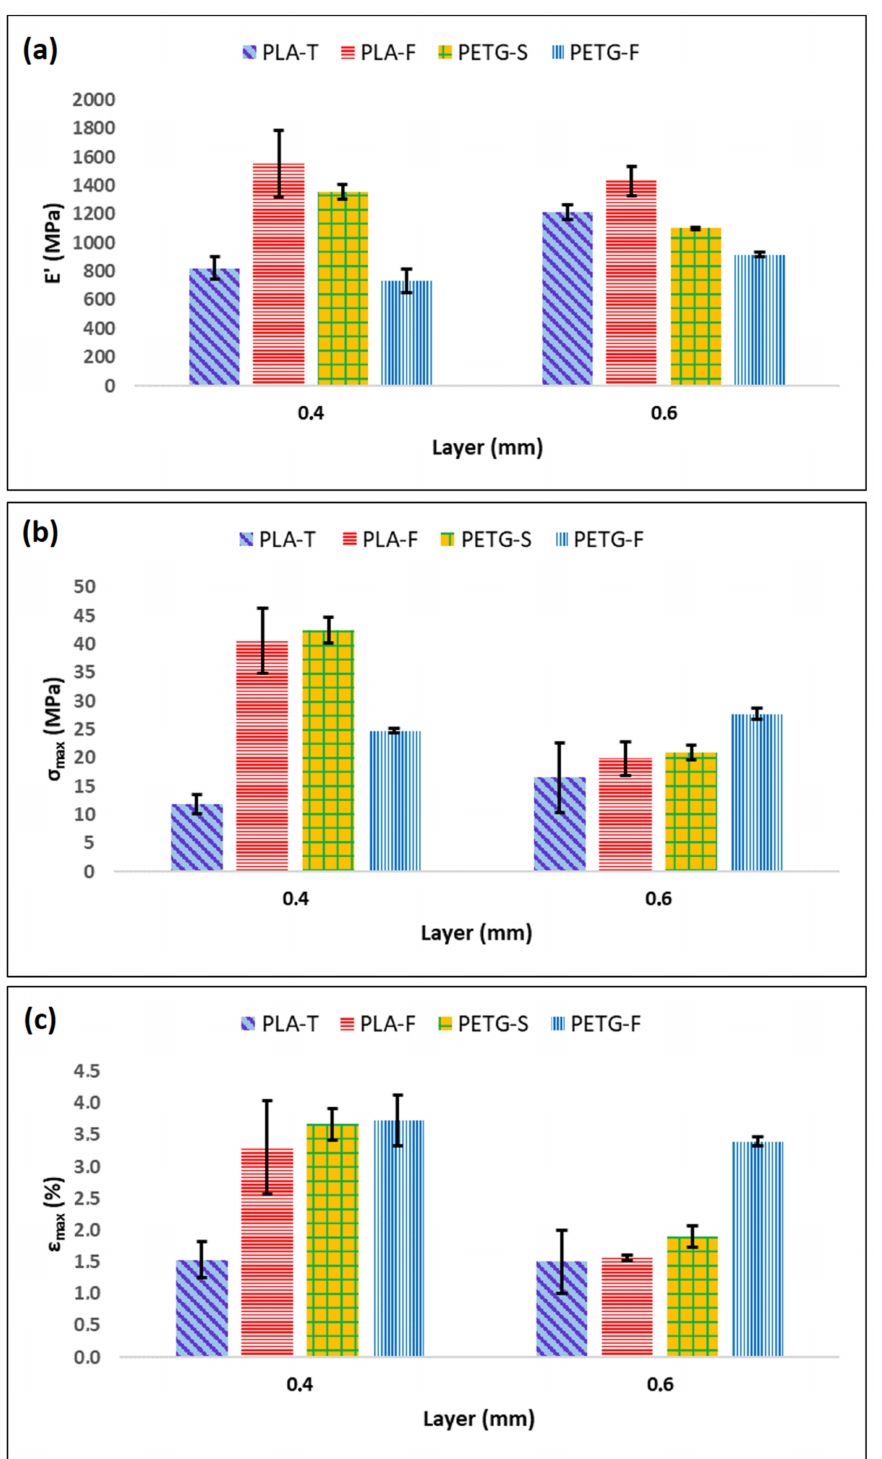
Figure 7. Mechanical properties of PLA and PETG samples in (0,0,1) direction as a function of the layer thickness. ( a ) represents the elastic modulus (E (cid:48) ), ( b ) the yield strength ( σ max ) and ( c ) the elongation at break ( ε max